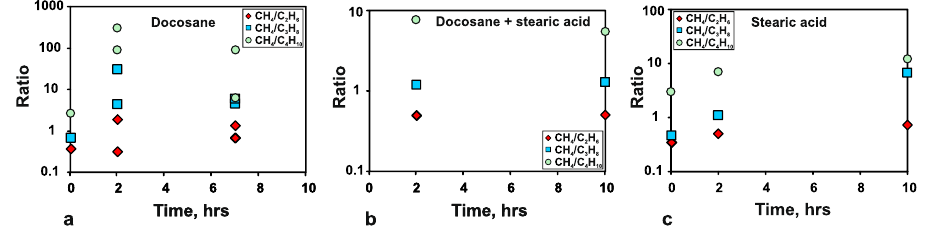
Figure 2. Normalised peak area ratios of CH 4 /C 2 H 6 , CH 4 /C 3 H 8 and CH 4 /C 4 H 10 as a function of duration, according to GC-MS analysis of quenched fluids synthesised at 6.3 GPa and 1400 °C from different starting